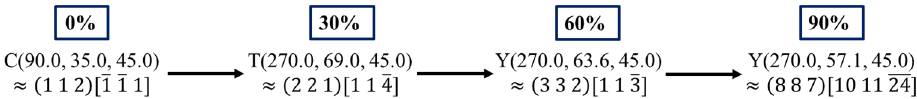
Figure 8. The {2 0 0} pole figures of fcc metals simulated using MTCS-model with single C orientation after the reduction ratios of ( a ) 30%, ( b ) 60%, and ( c ) 90%. △ , ▲ , and ◆ are the pole positions on {2 0 0} pole figure of the orientation close to C (1 1 2)[1(cid:3364) 1(cid:3364) 1] , T (5 5 2)[1 1 5(cid:3364)] , and Y (1 1 1)[1 1 2(cid:3364)] , respectively.